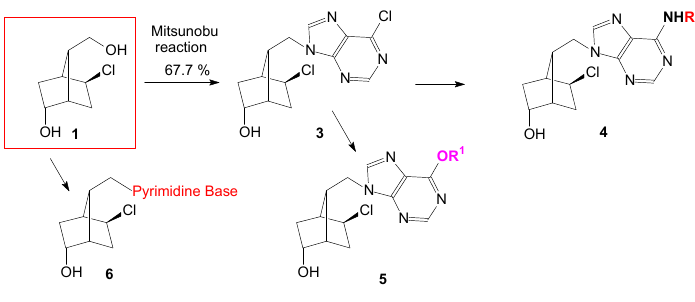
Figure 1. New carbocyclic nucleosides with a constrained norbornane scaffold as sugar